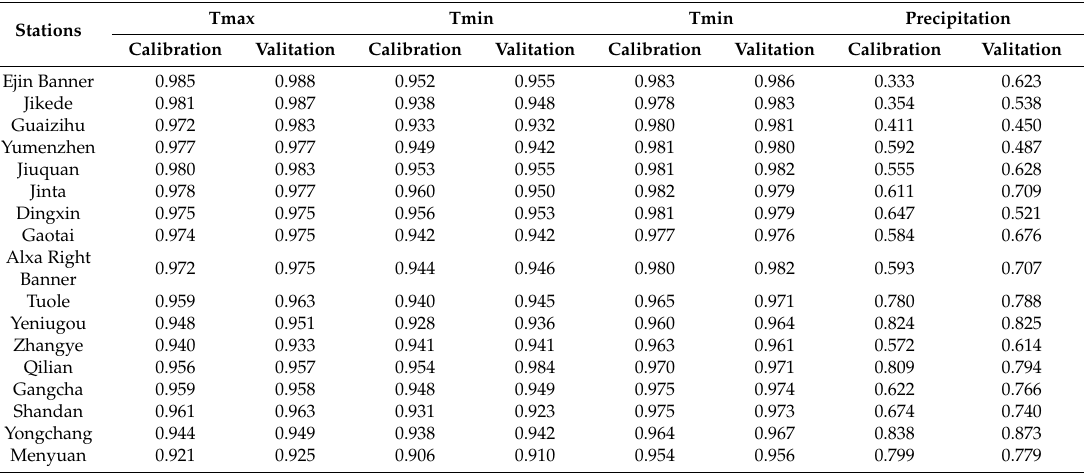
Table 6. Nash–Sutcliffe efficiency coefficient ( NSE ) results of the SDSM during calibration and validation